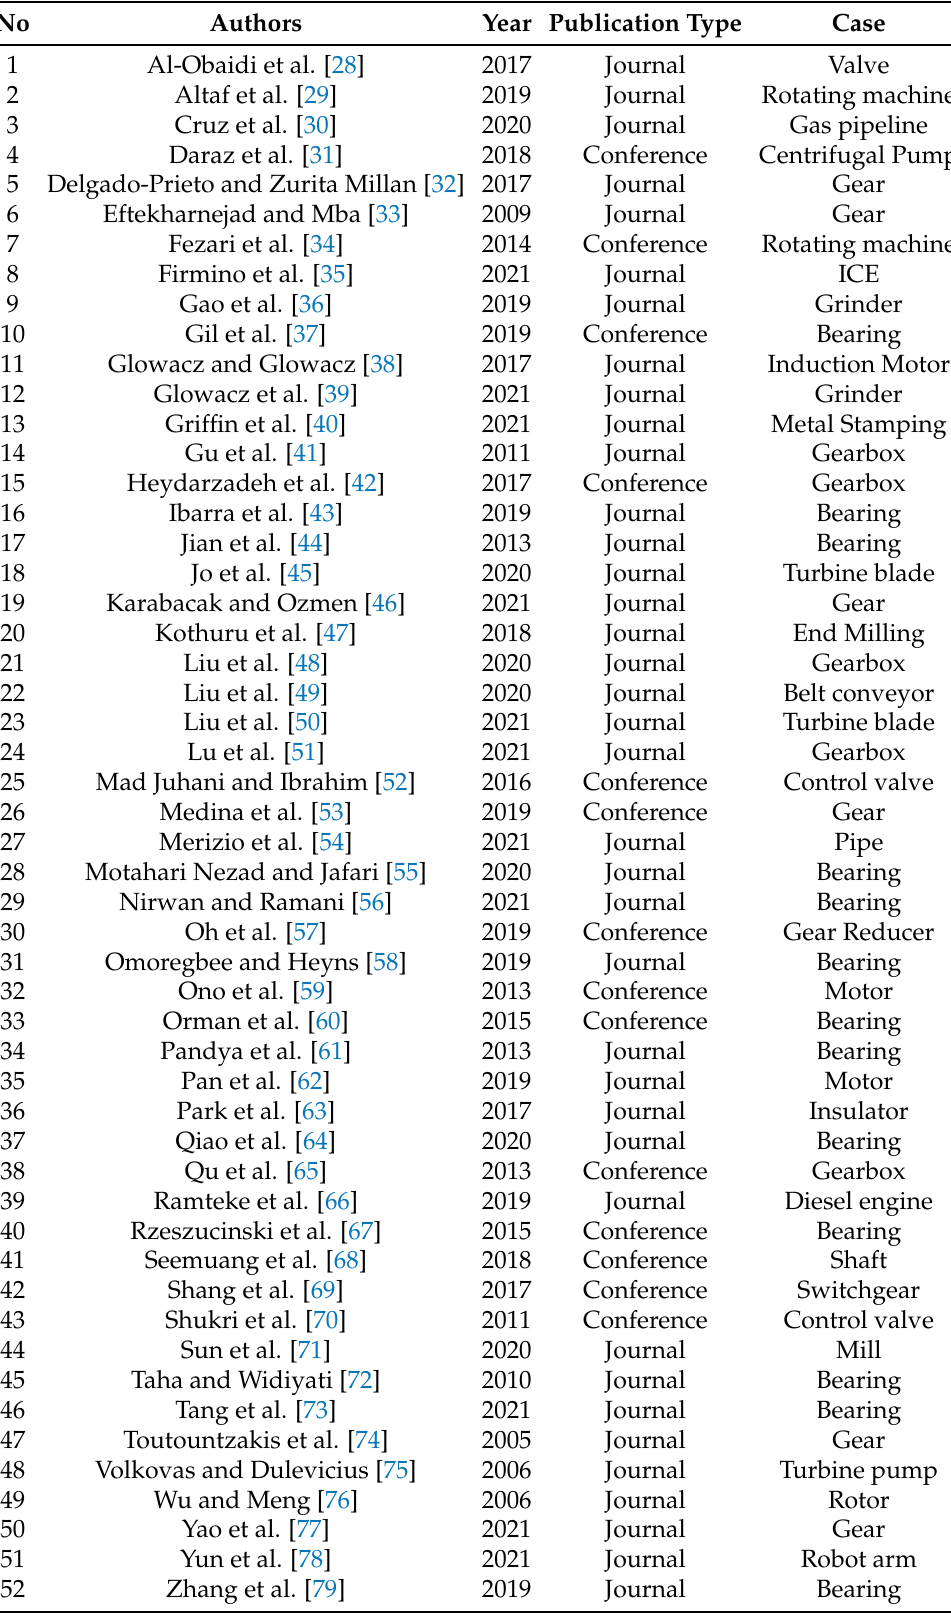
Table 5. List of selected